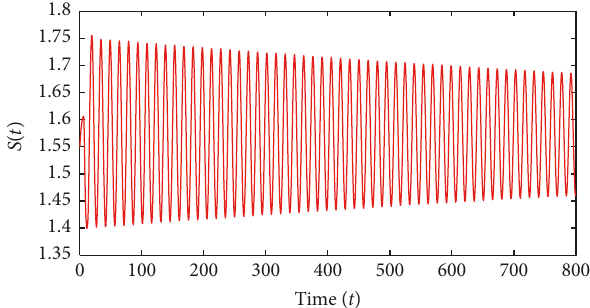
Figure 2: 𝑃 ∗ lose its stability when 𝜏 = 6.1752 > 𝜏 0 = 5.3442 with initial functions “1.55, 0.79, 0.136, 0.75.”